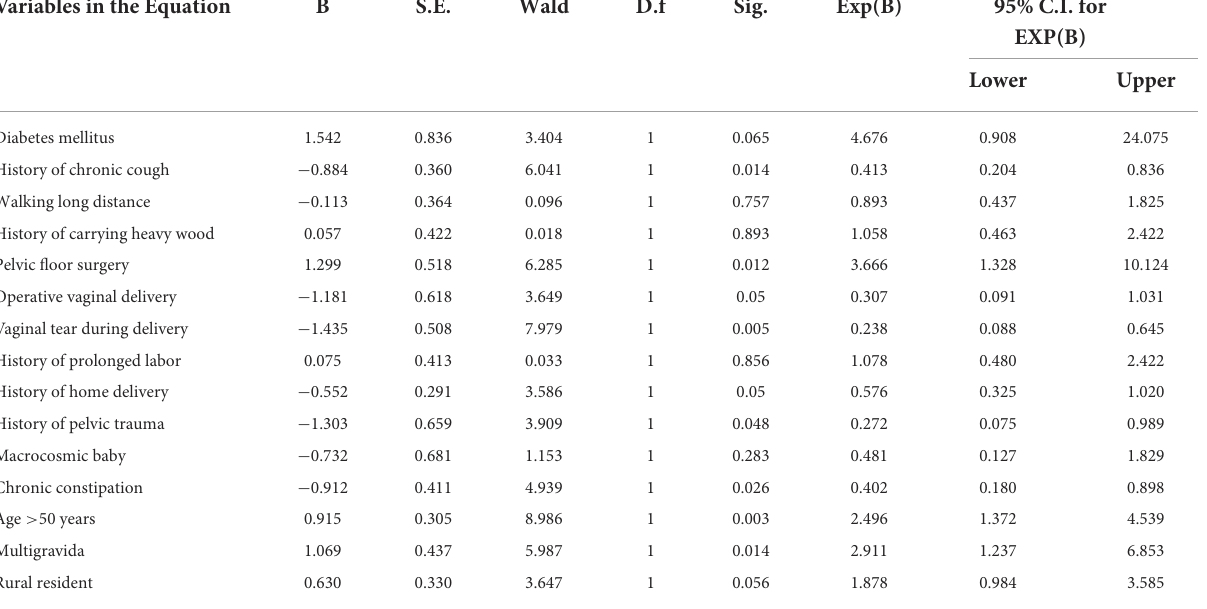
TABLE 4 Risk of pelvic organ prolapse at ATRH, 2021. Variables in the Equation